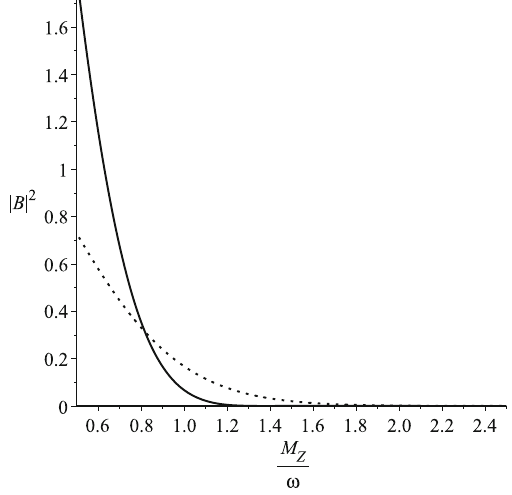
Fig. 2 Real part of B k as a function of parameter M Z /ω . Solid line is for p = 0 . 5 , p (cid:11) = 0 . 4 , P = 0 . 1, while the point line is for p = 0 . 2 , p (cid:11) = 0 . 4 , P = 0 . 4